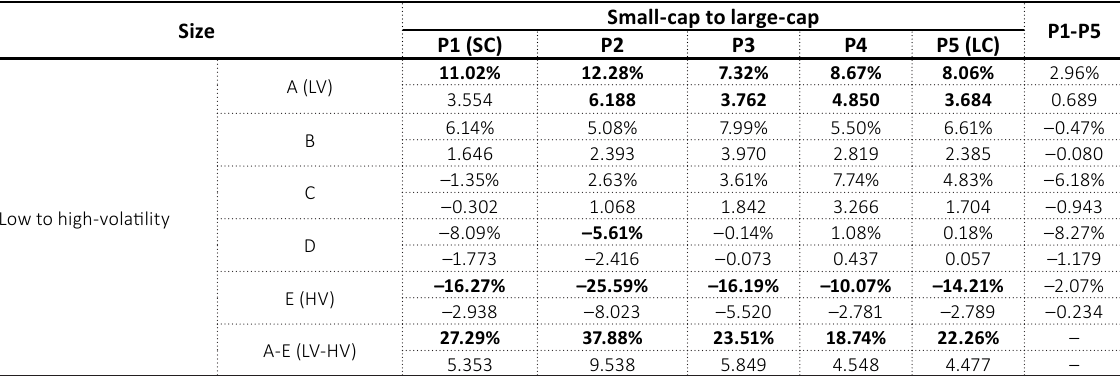
Table 7. C APM style alpha of quintile portfolios independently sorted on size and